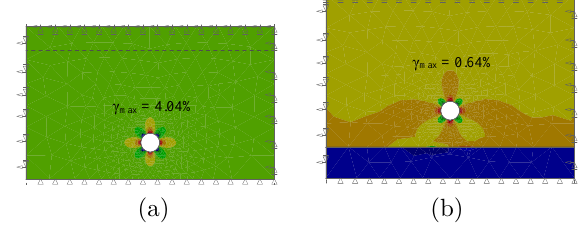
Figure 8. Distribution of shear strain: a) Model- 1, loading from Fig. 6(a), b) Model-2, loading from Fig. 6(b).